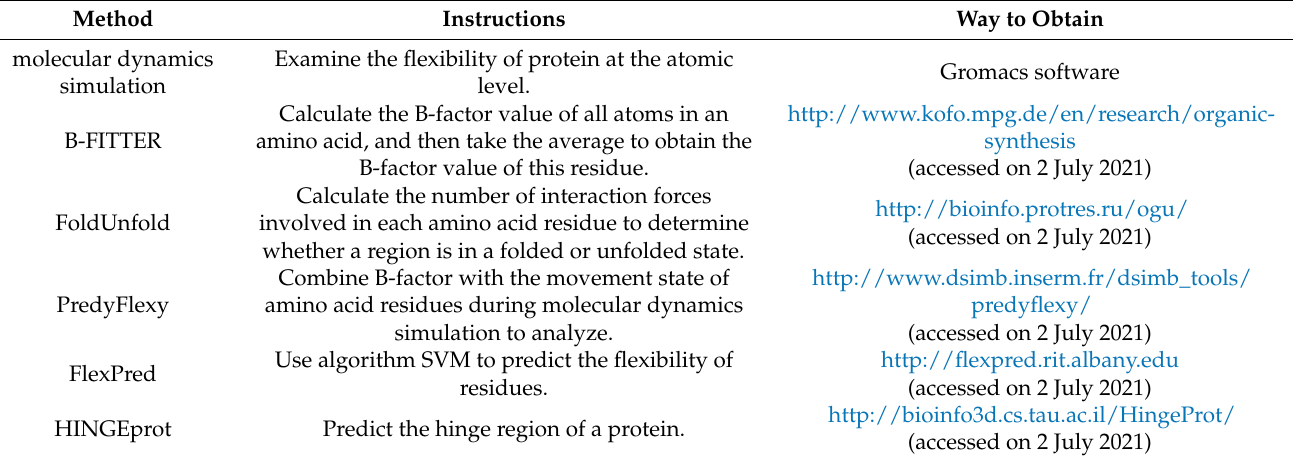
Table 2. Common methods for predicting flexible regions in proteins.